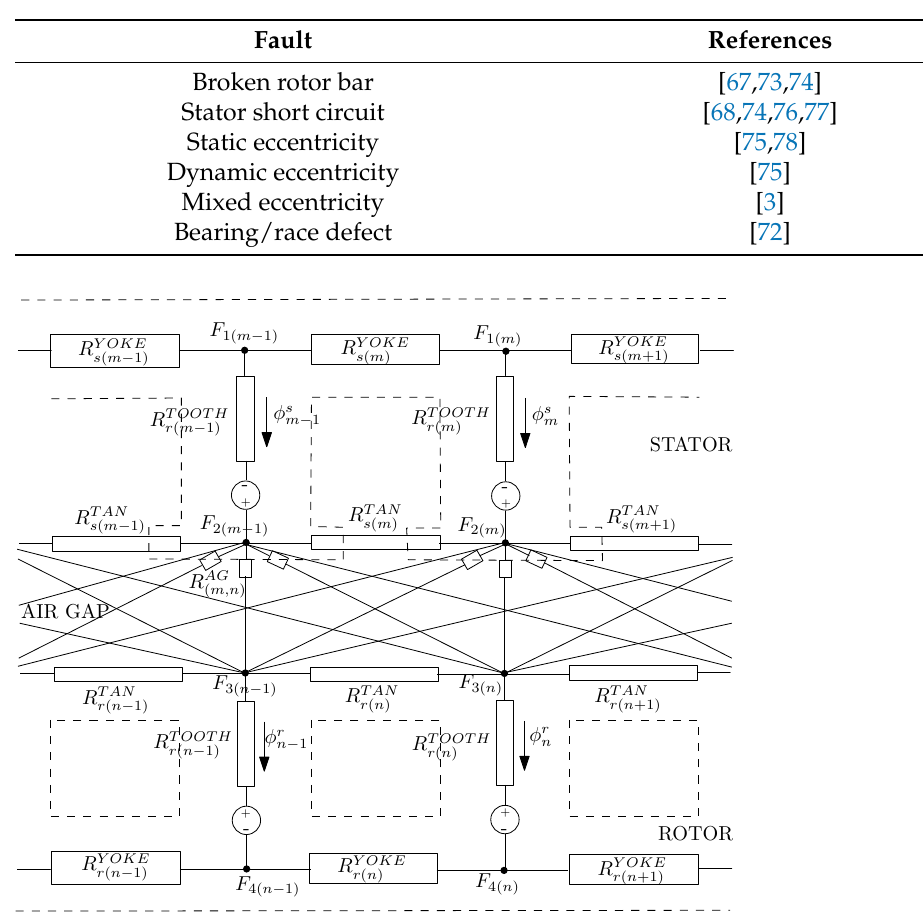
Table 3. MEC references for common faults.